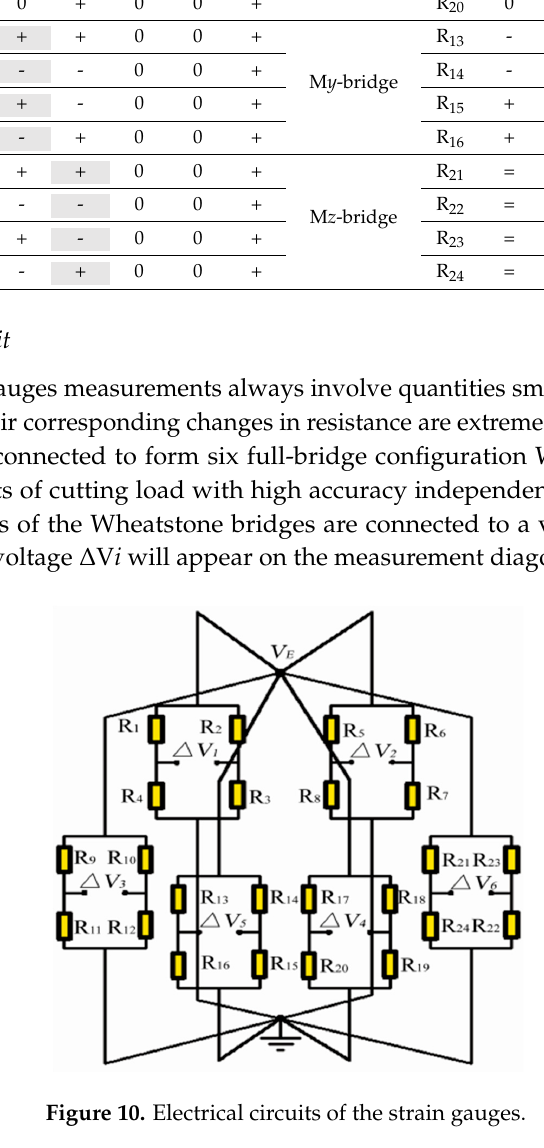
Table 4. Variations of resistances of strain gauges.